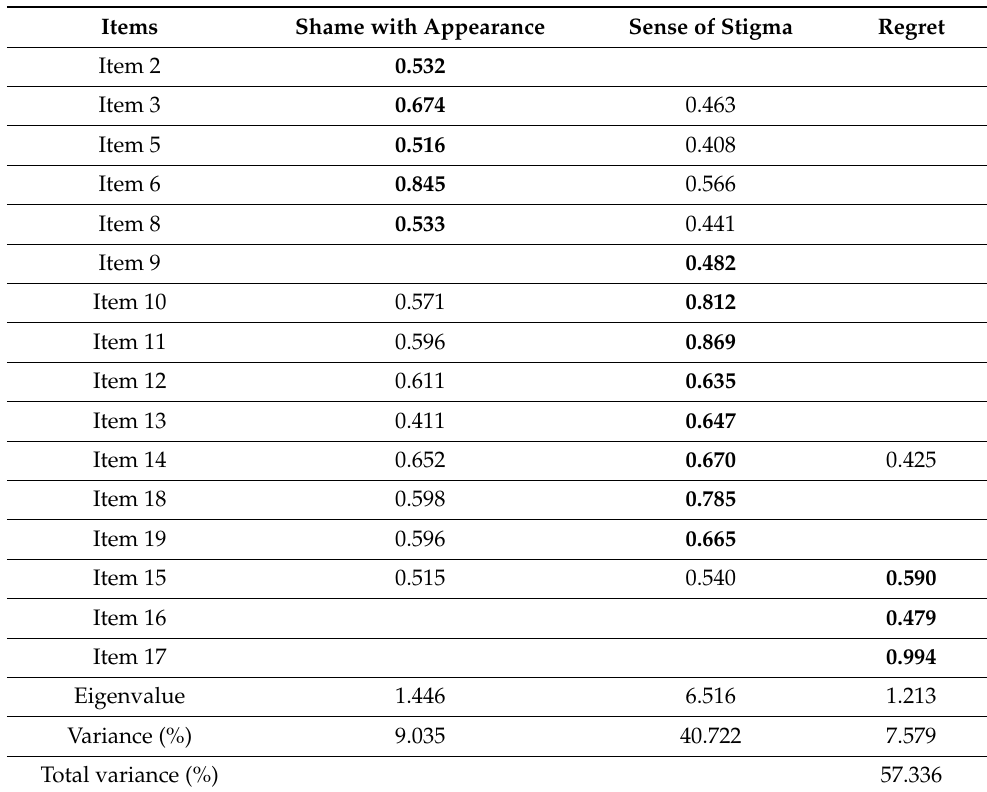
Table 4. Exploratory factor analysis using the maximum likelihood estimation with Promax rotation and Kaiser normalization for the SSS-M (3-factor